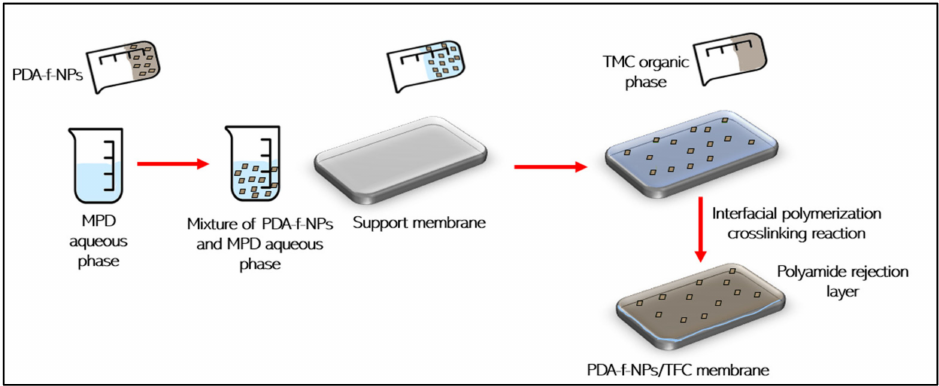
Figure 6. Embedding PDA-f-NPs into MPD aqueous phase followed by creating PA rejection layer by interfacial polymerization crosslinking